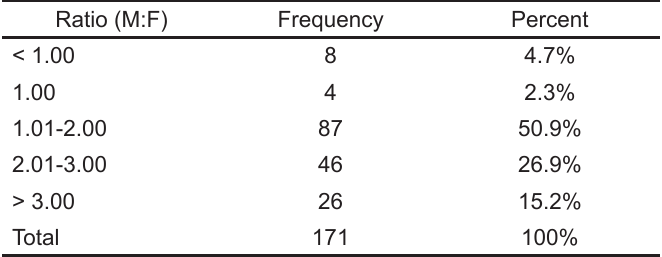
Table. Frequency of gender ratios among emergency medicine (EM) residents from 2014-2017 from 171 EM programs. Ratios listed as male:female